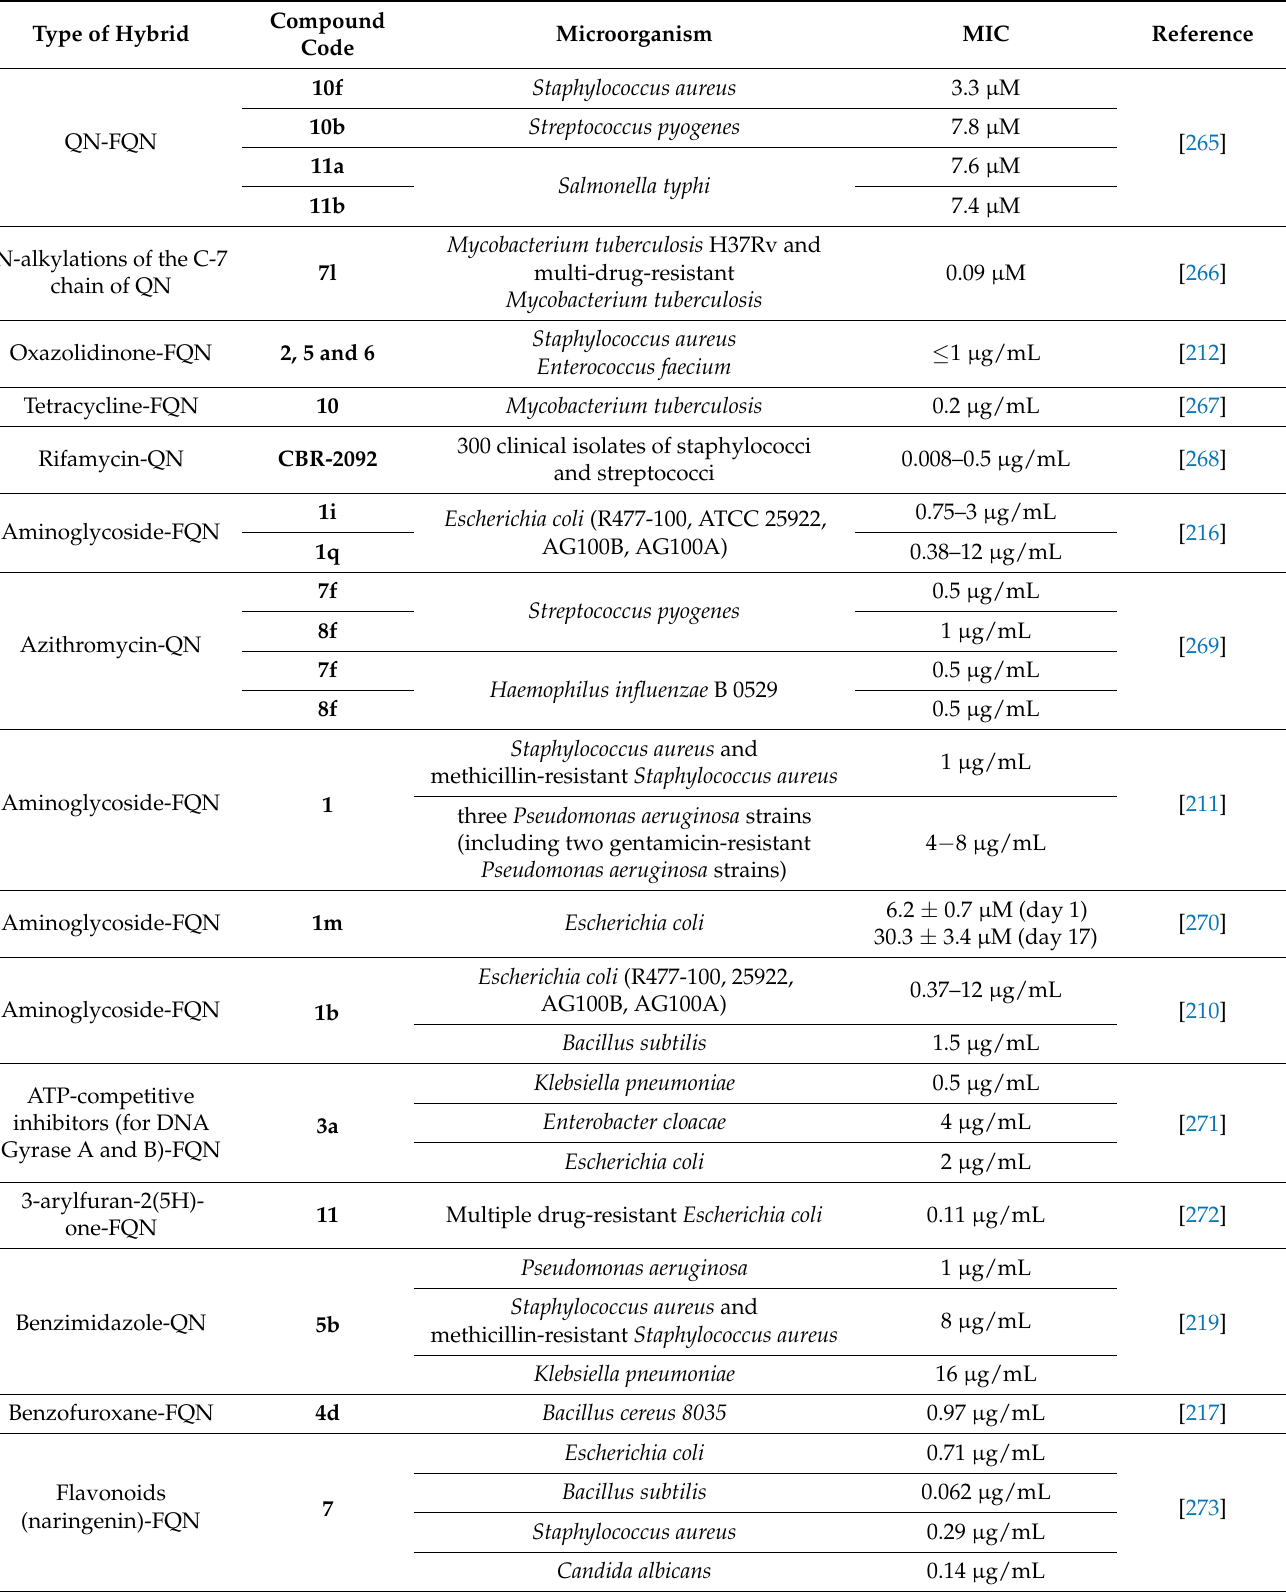
Table 5. The antimicrobial activity of QN/FQN hybrids (represented through